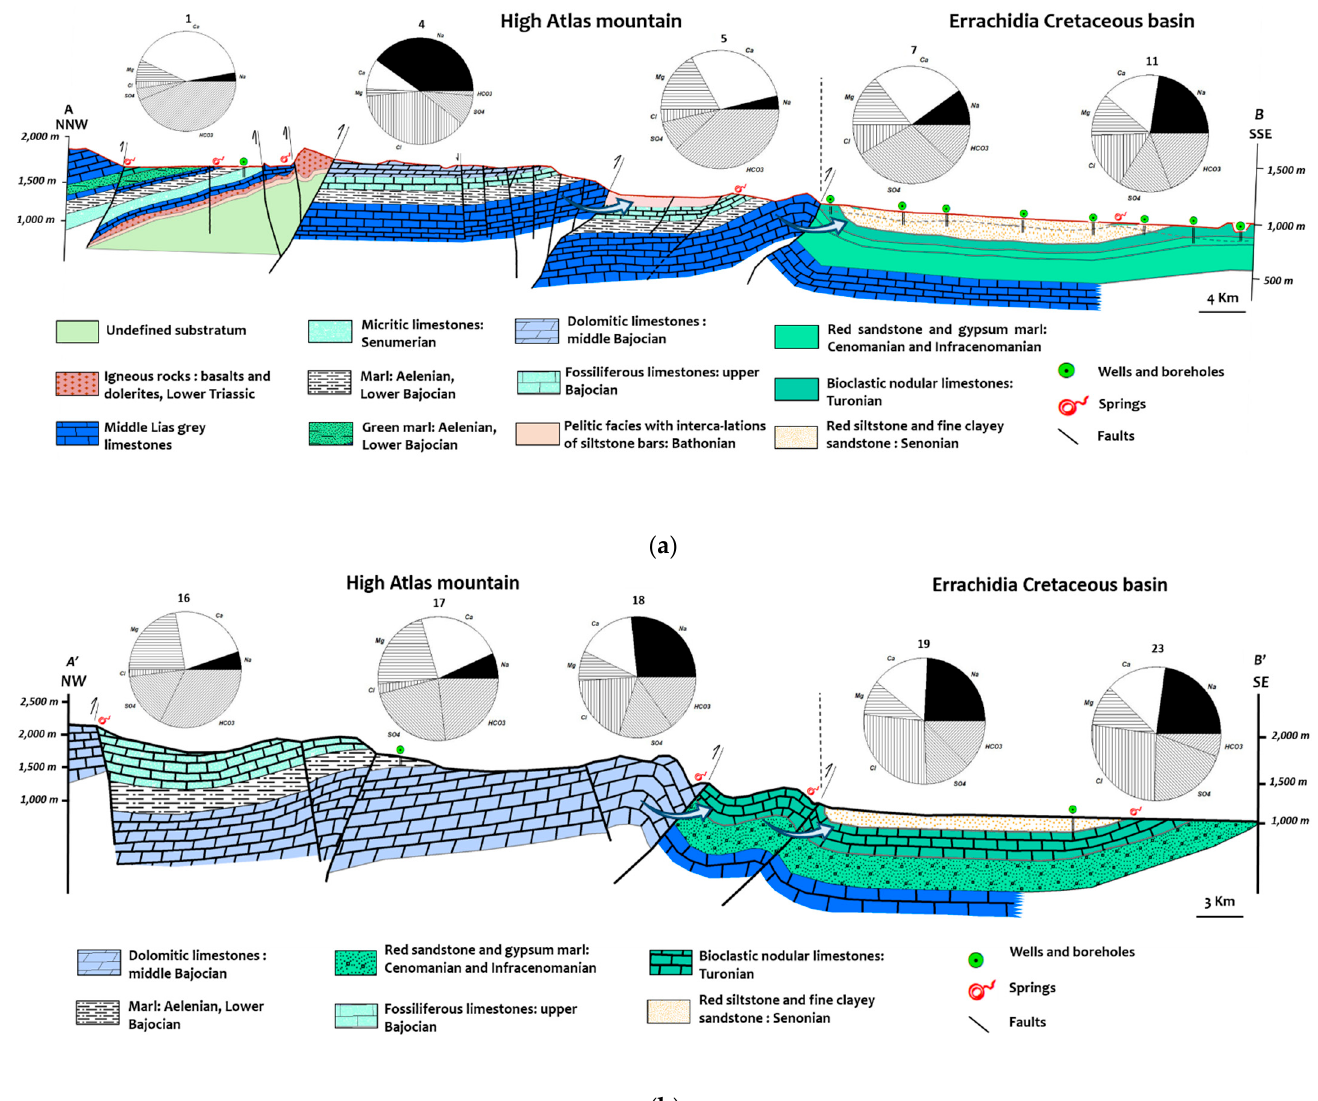
Figure 11. Northwest-southeast geological cross sections in the study area showing hydrogeological connections and geological structure between the high Atlas and Cretaceous basin with chemical composition (pie diagram) showing groundwater evolution along the flow path. ( a ) cross section AB; ( b ) cross section A’B’ (Figure 1) .